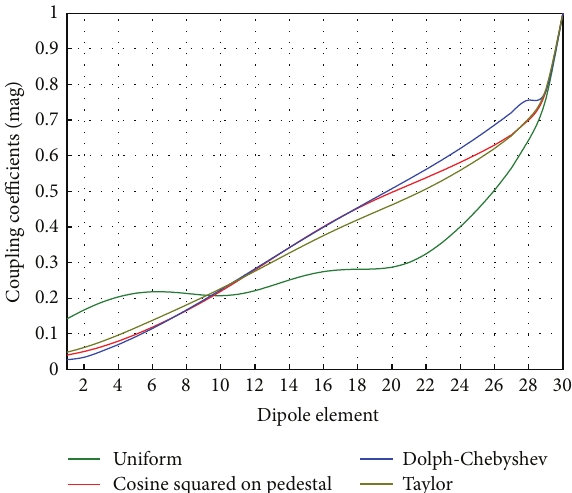
Figure 6: Coupling coefficients for different amplitude distributions in a series-fed linear dipole array; side-by-side configuration. 𝑑 = 0.1 𝜆 .